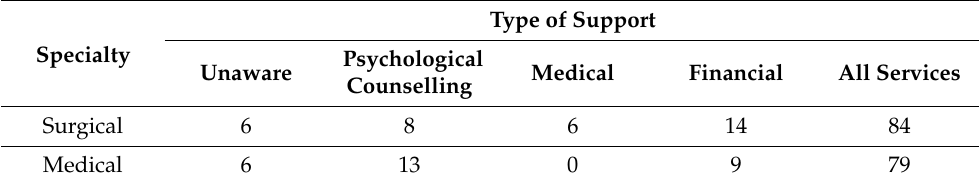
Table 3. Suggested services to be provided for employees at COVID-19